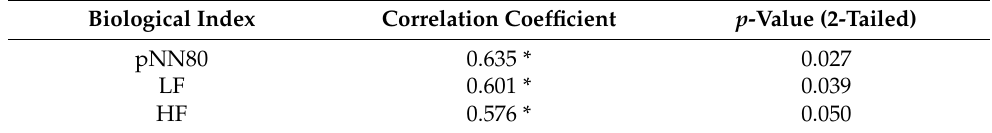
Table 10. Correlation coefficients between the number of errors in Task1 and the mean values of biological indexes during the first half of Task1 (* correlation is significant at the 0.05